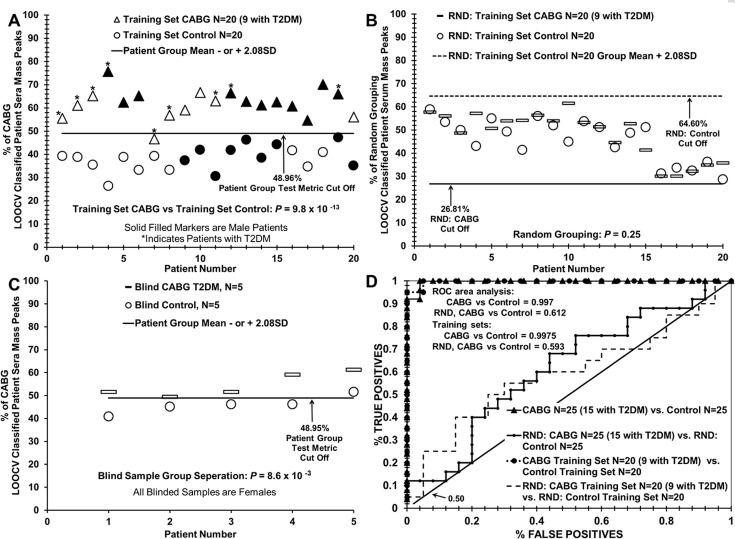
Analysis of “blind” or “left out” sets of subject sera samples using training a set composed of CABG patients versus control individuals.(A) Training set of serum discrimination of CABG patients (triangles) from controls (circles) by % of CABG LOOCV classified mass peaks; one false negative is observed. (B) Non-serum sample discrimination observed when the two different sample groups in panel A are mixed together randomly followed by the same LOOCV mass peak analysis. (C) Assessing the ability of the training set in panel A to correctly discriminate a blinded group of ten samples; 9 out of 10 samples were correctly identified. (D) Receiver operator characteristic (ROC) curve analysis of LOOCV data in Fig 4 and Fig 5. ROC analysis exhibits high sensitivity (true positive rate) of the group binary comparisons in Fig 4 panel A and Fig 5 panel A, and the near random results for the inter-group sample randomizations in Fig 4 panel B and Fig 5 panel B; the horizontal line exhibits a complete random result.